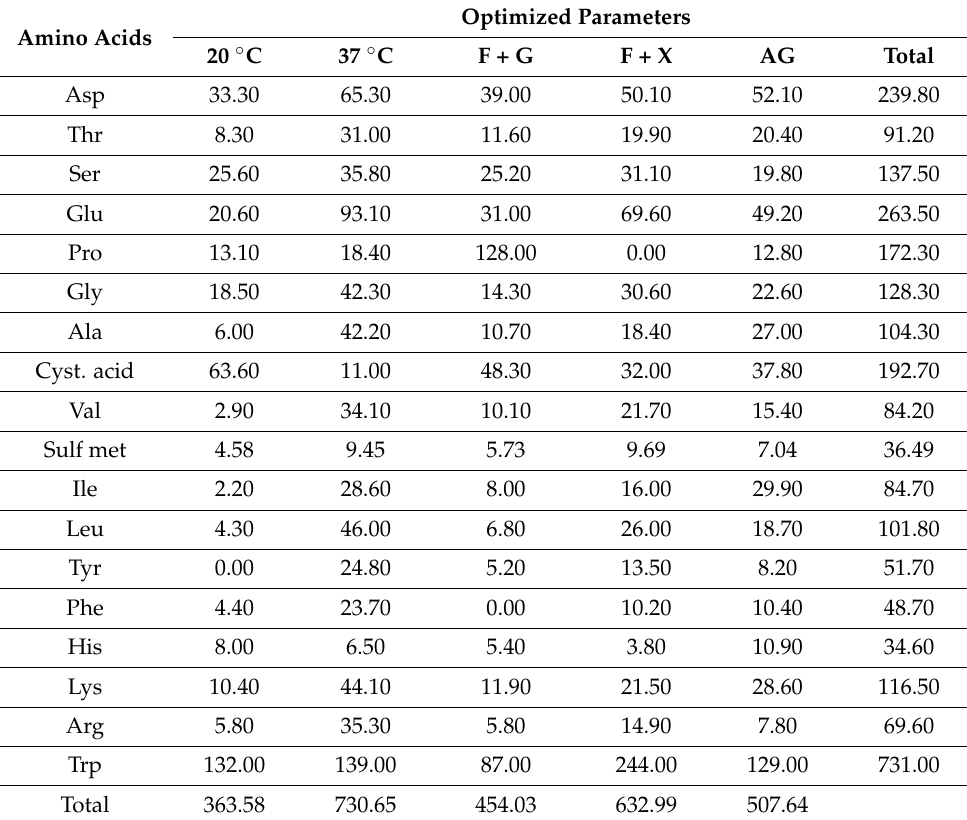
Table 5. Amino acid composition [ µ g g –1 ] of 18–day culture fluids of Trichophyton ajelloi strain